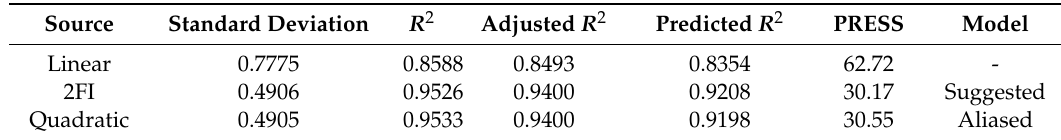
Table 6. Statistics analysis to select the fitting model for